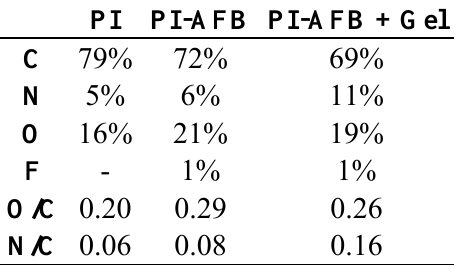
Table 2. Atomic surface composition of PI, PI-AFB and gelatin-coated PI acquired by means of